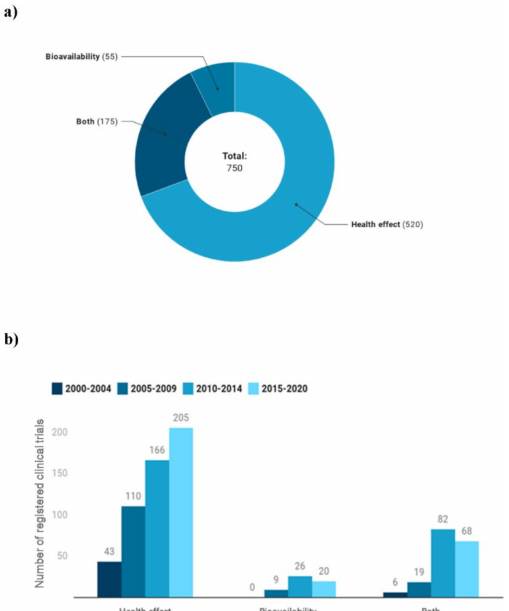
Figure 7. Number ( a ) and trend ( b ) of studies assessing the bioavailability or the health e ff ects of